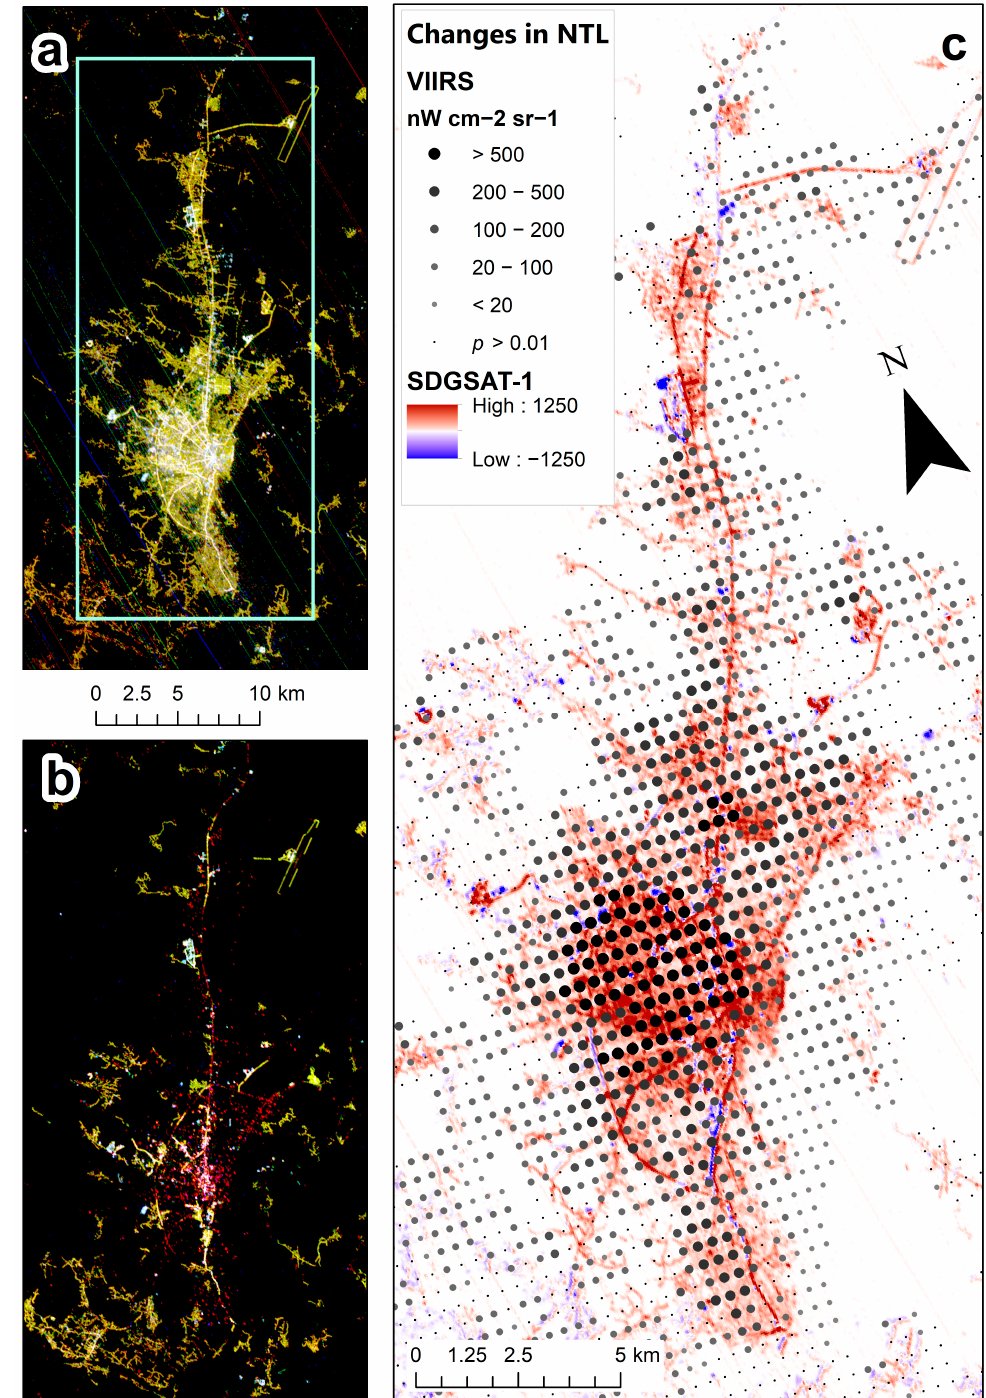
Figure 6. ( a ) SDGSAT-1 nighttime image acquired on 22 August 2022; ( b ) SDGSAT-1 nighttime image acquired on 12 February 2023; ( c ) statistically significant changes in VIIRS NTL ( p < 0.01), comparing the 36 days before the 6 February earthquakes and the 14 days after the 6 February earthquakes. Positive values of NTL changes signify a decrease in NTL. Very few areas with statistically significant changes in NTL were found outside of the area shown on the map. Small black dots represent VIIRS lit grid cells, where no statistically significant changes in NTL were found.